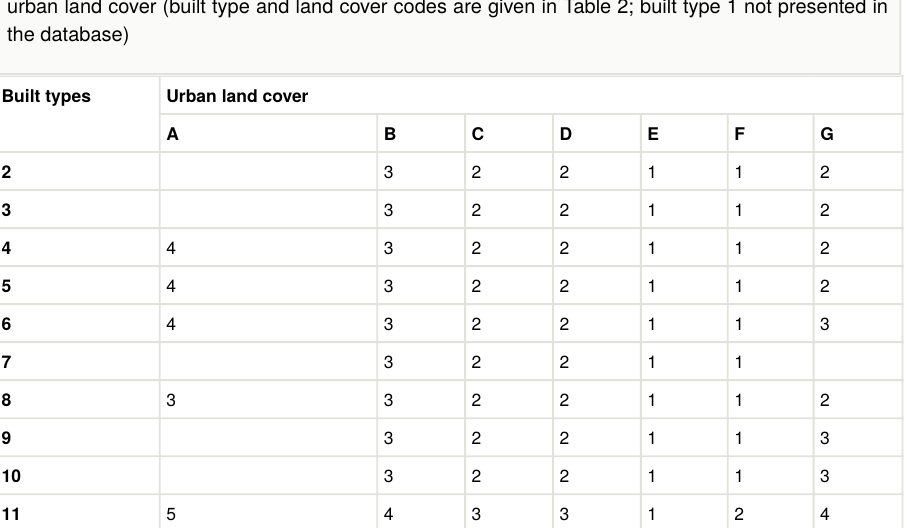
Figure 3. Conceptual scheme for calculation of vegetation cover.